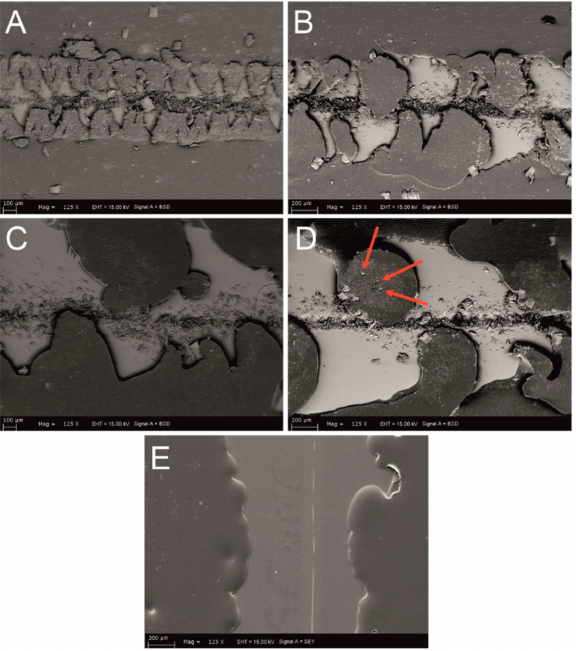
Figure 4. SEM micrographs of coating surfaces after the scratch test. ( A ) Coat1, ( B ) Coat2, ( C ) Coat3, ( D ) Coat4, and ( E )